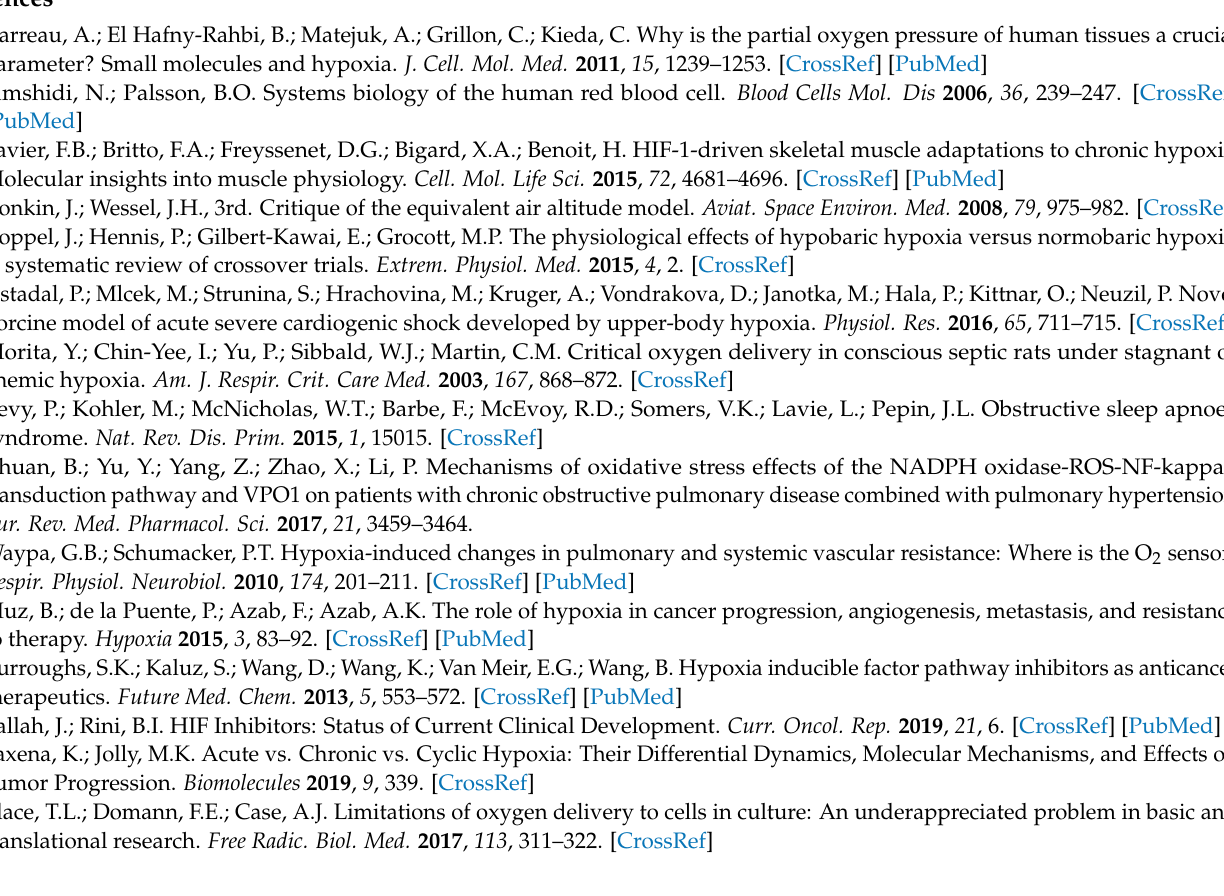
Figure S1: Photo of the experimental setup to generate cyclic oxygen gradients in a microfluidic device and perform real-time fluorescence imaging, Figure S2: Phase contrast and fluorescence images of (a) AoSMC and (b) A549 cells cultured in the microfluidic devices and stained with X-Rhod-1 dye for intracellular calcium